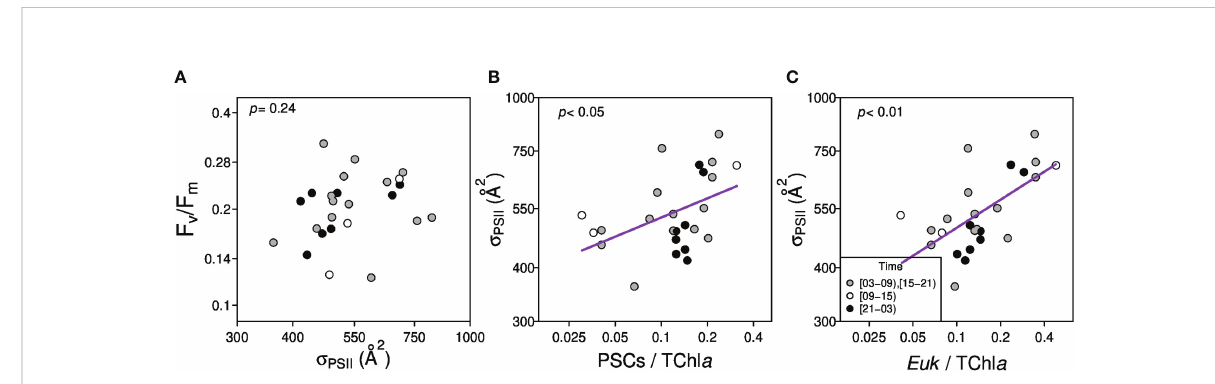
FIGURE 9 The relationship between F v /F m and s PSII (A) ; s PSII and photosynthetic carotenoids (PSCs)/TChl a (B) ; s PSII and Euk /TChl a (C) . The color represents the time period with the legend in panel ( C ). Euk was short for eukaryotic phytoplankton.